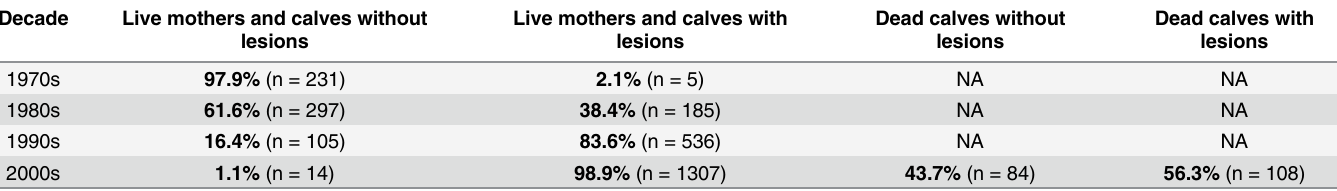
Table 2. Percent of living mother-calf pairs and dead calves with and without lesions by